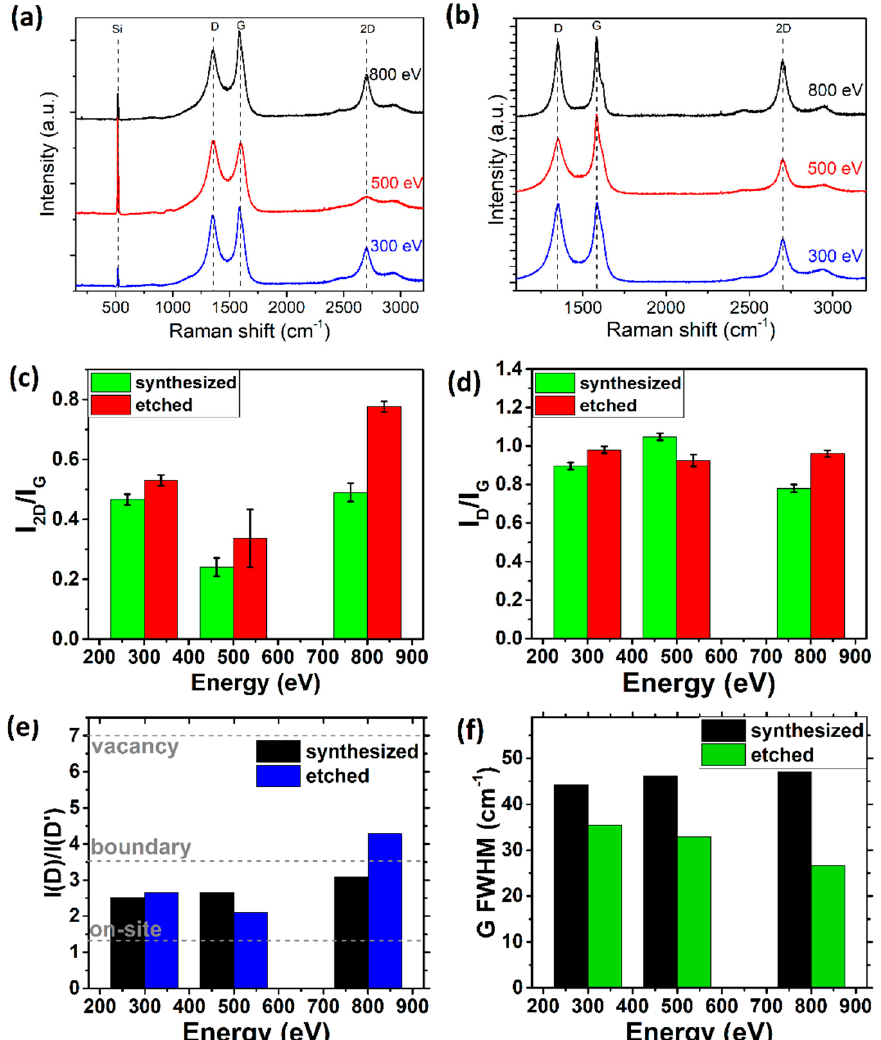
Figure 4. The hydrocarbon ion-beam energy effects on the structure of graphene: the Raman spectra after synthesis ( a ) and after removing the sacrificial cobalt interlayer ( b ); Raman spectra parameters analyzed: I 2D /I G ( c ); I D /I G ( d ); I D /I D’ ( e ); FWHM(G) ( f ). The Co layer was 25 nm thick, synthesis temperature—700 °C, ion beam treatment time—15 min.